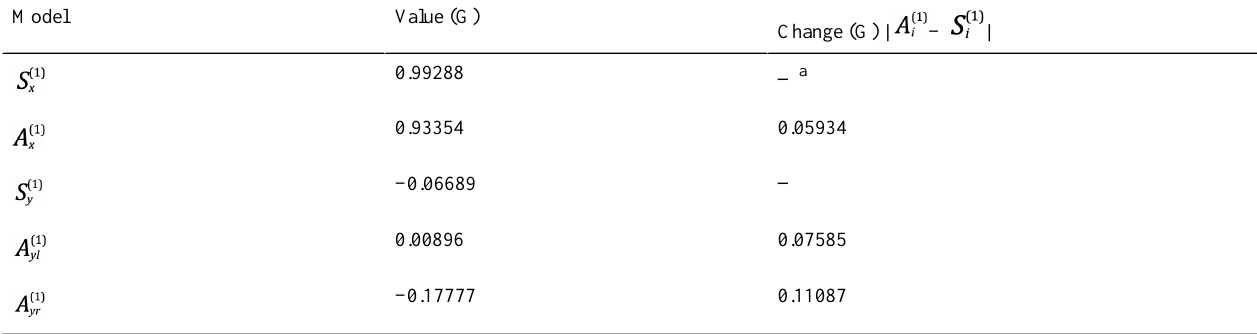
Table 1. Measurement results of user number 1 based on orthopedists’standards.